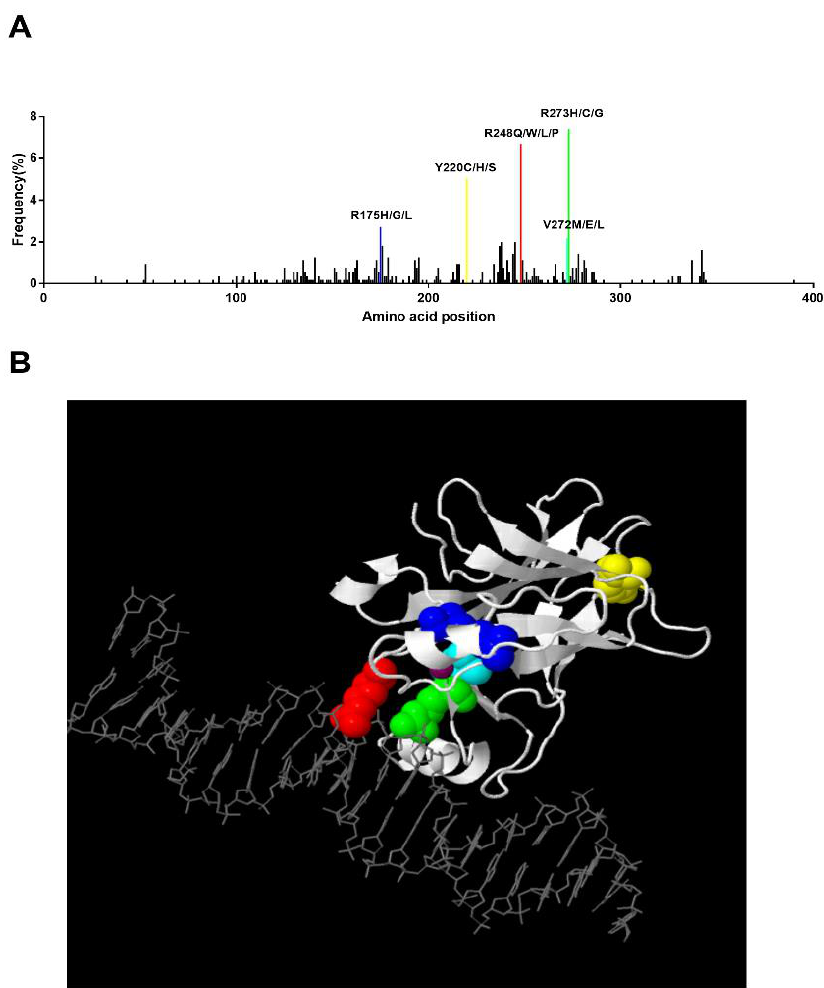
Figure 2. Hotspot TP53 mutations in MDS and the corresponding 3-D structure. ( A ) Distribution of identified TP53 mutations in MDS. The frequency of each mutation was calculated upon pooled data extracted from the IARC TP53 Database (2019) and Bernard et al.’s study. Hotspot mutations with a frequency higher than 2% are labeled [14,43]. ( B ). Three-dimensional view of TP53 binding to DNA. This structure was generated by JSmol software in IARC TP53 database. Residue 175: blue, Residue 220: yellow, Residue 272: cyan, Residue 273: green, Residue 248: red. Zinc: purple.